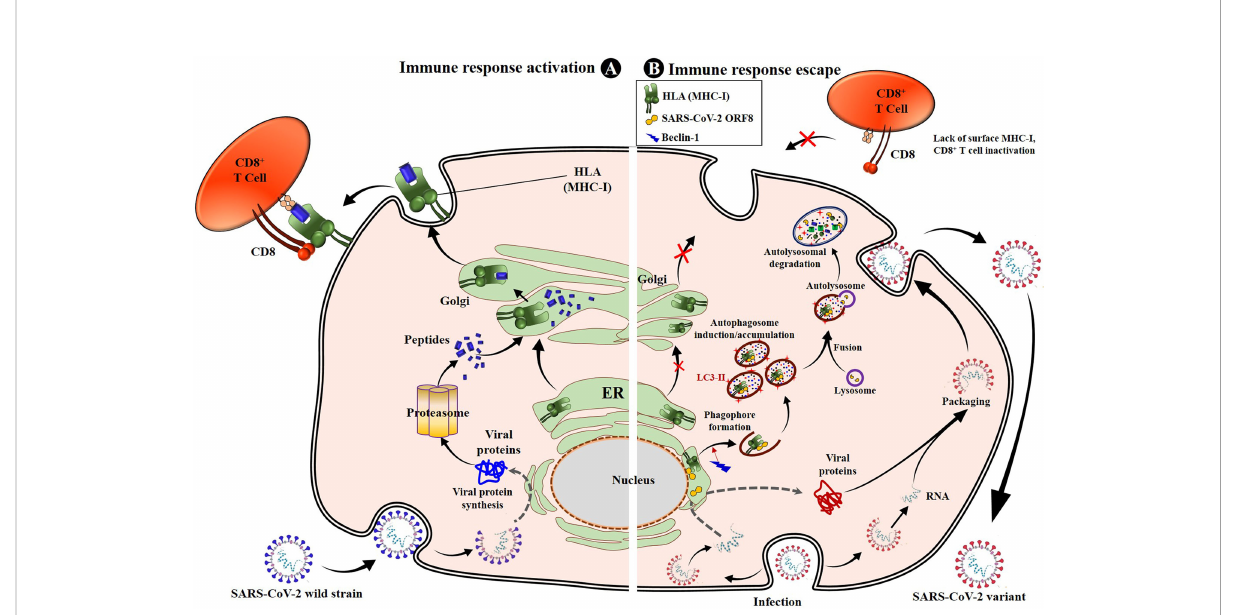
FIGURE 1 SARS-CoV-2 impairs antigen presentation by MHC-I to CD8+ T cells through ORF8. Once entered into the epithelial cells by endocytosis, the genomic RNA is released. SARS-CoV-2 uses the cell protein expression machinery to synthesize the viral proteins. The antigen processing and presentation pathways occur for viral protein lysis into peptides. Simultaneously, the MHC-I will mature in the ER and migrate to the Golgi apparatus, where peptides will be loaded onto MHC-I molecules and presented to CD8 + cytotoxic T lymphocytes (CTLs), activating the cell cytotoxic response (A) . When infected with SARS-CoV-2, especially variants of concern, the viral proteins, including the ORF8, are produced inside ER-derived DMVs containing LC3-I. The synthesized ORF8 protein directly interacts with the MHC-I and leads MHC-I traf fi cking from